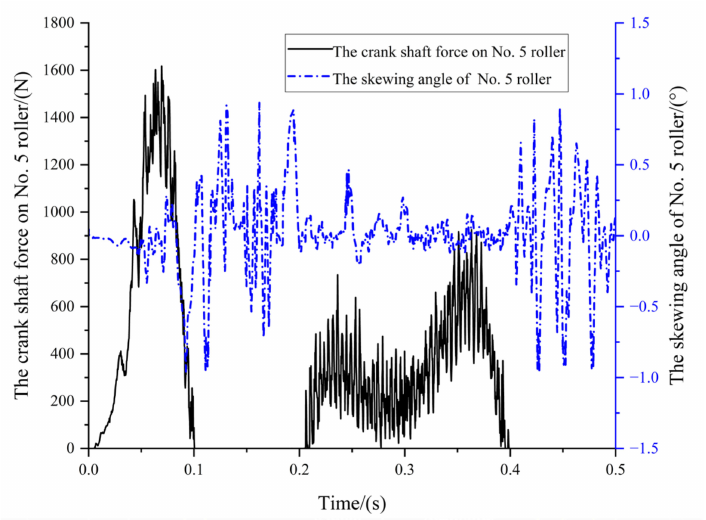
Figure 17. The crank shaft acting force on the No. 5 roller and variation of the skewing